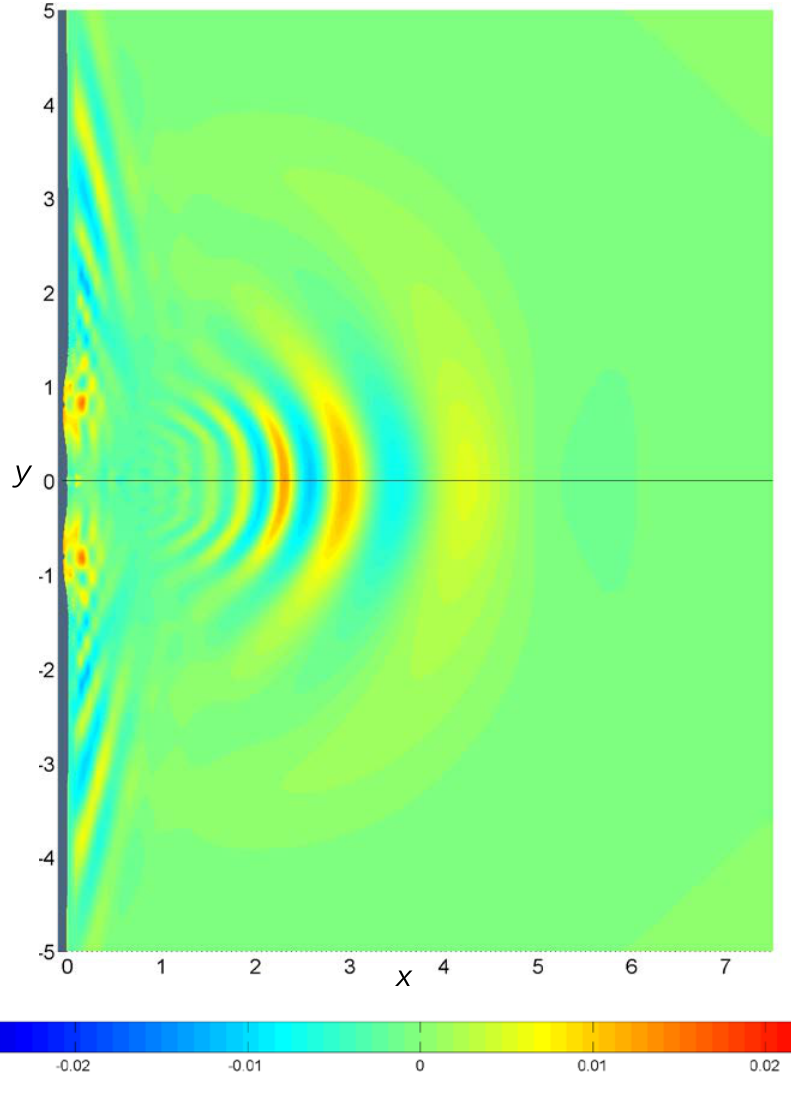
Figure 17. Distribution of the free surface elevation at t = 3.9 s in case 1 in a wider wave flume.